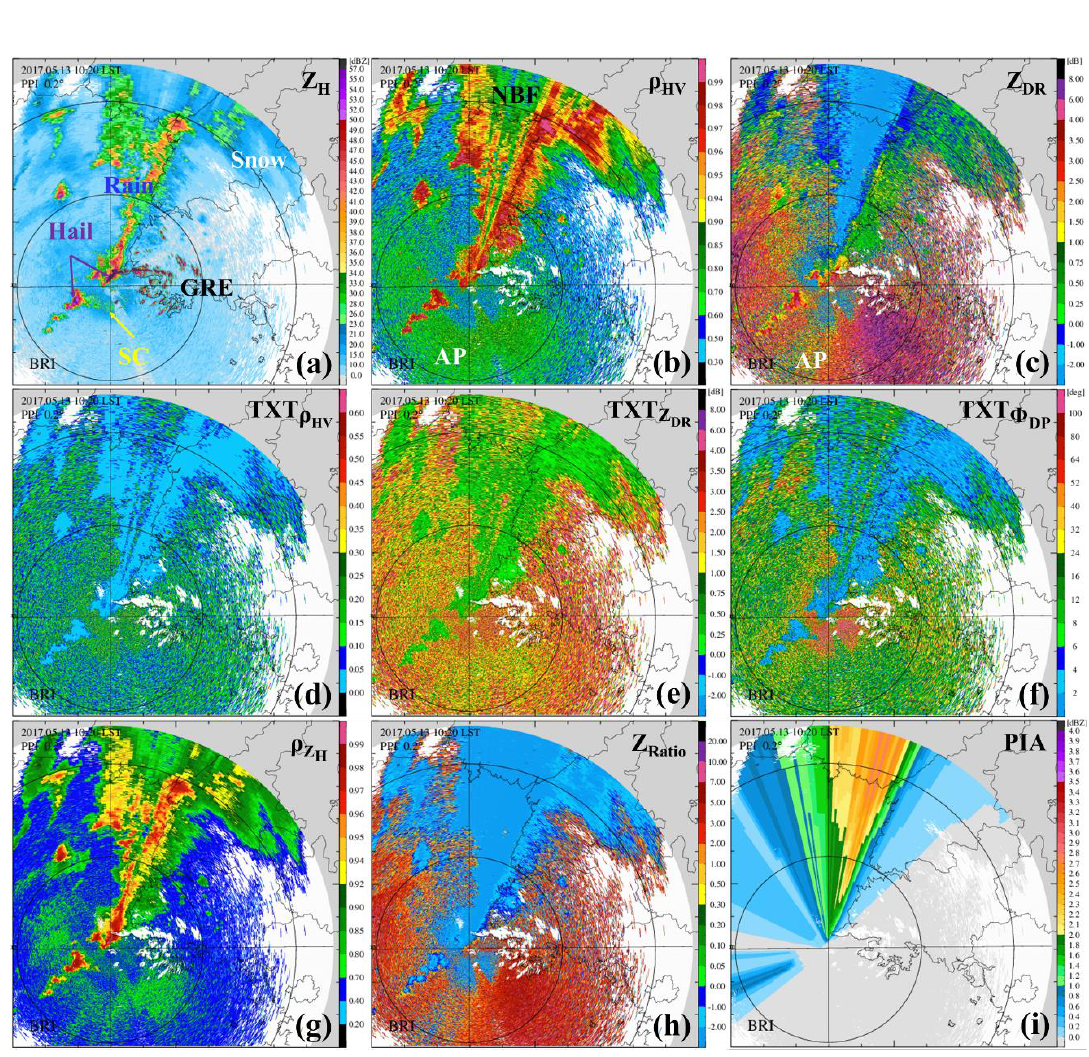
Figure 6. Polarimetric observations of ( a ) 𝑍 𝐻 , ( b ) 𝜌 𝐻𝑉 , and ( c ) 𝑍 𝐷𝑅 and ( d – f ) the generally-used feature parameters of radial texture of 𝜌 𝐻𝑉 , 𝑍 𝐷𝑅 , and 𝛷 𝐷𝑃 . ( g – i ) new feature parameters of CLEANER for the classification of non-precipitation echo from the BRI observations at 1020 LST 13 May 2017.